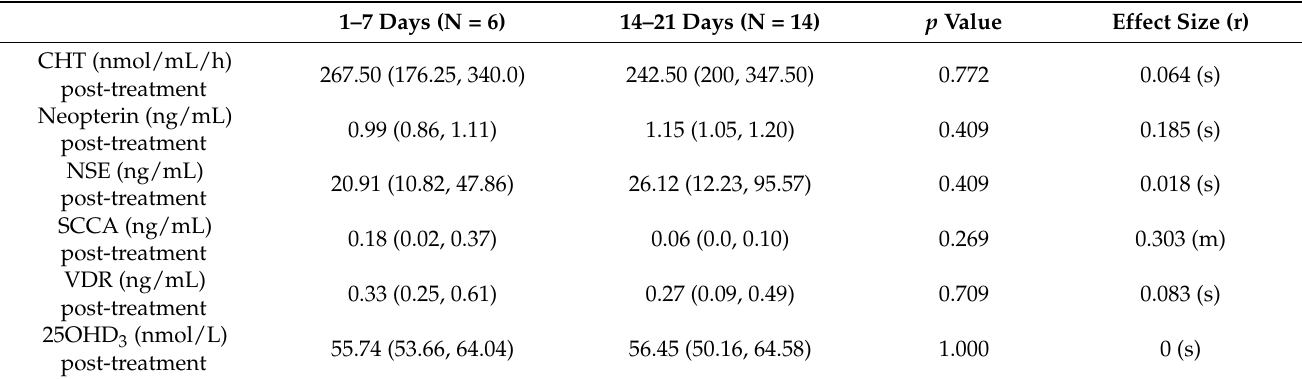
Table 2. The post-treatment values of a specific laboratory stratified by treatment